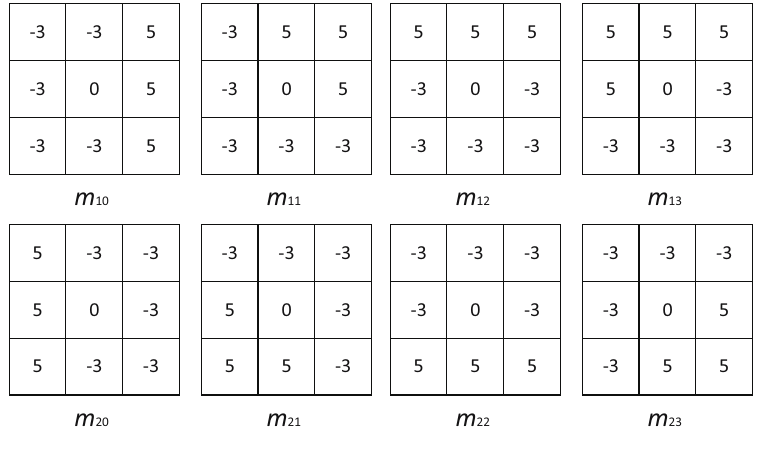
Figure 2: Kirsch